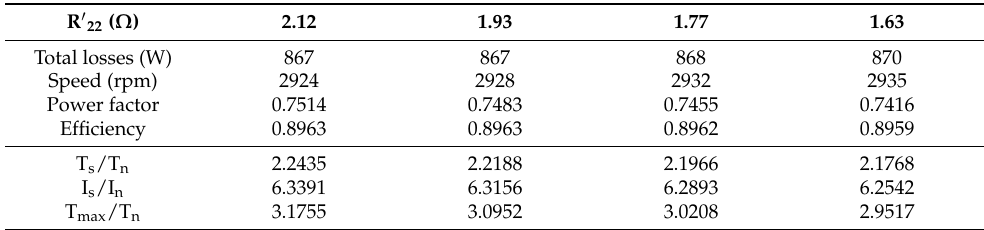
Table 8. Nominal, start, and maximum torque results on the 7.5 kW motor (equal output power criteria, variations of R (cid:48) 22